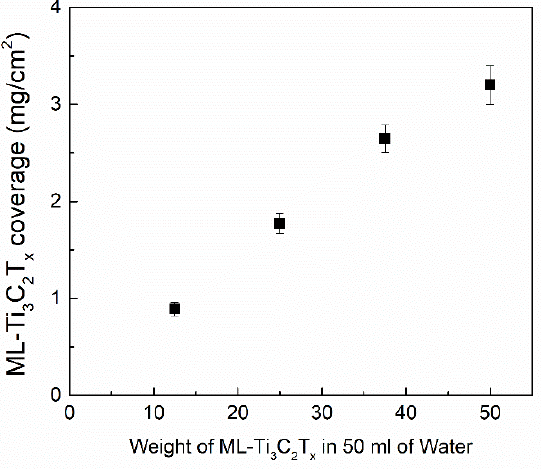
Figure 10. ML-Ti 3 C 2 T x density coverage for the membranes by using various concentrations of the ML-Ti 3 C 2 T x suspension.